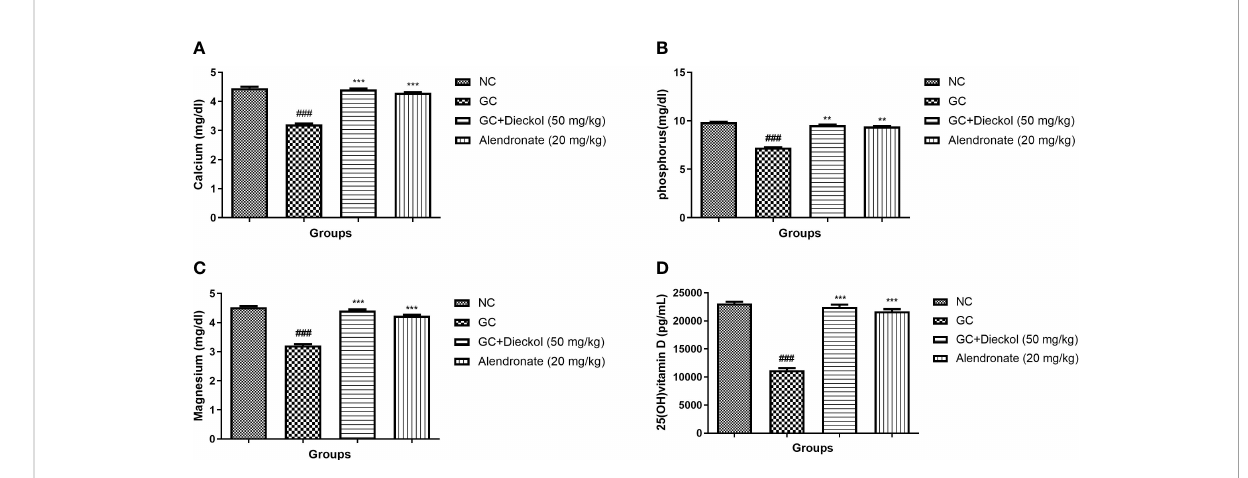
FIGURE 5 Dieckol was shown to protect nutrient parameters against glucocorticoid-induced osteoporosis in rats. (A) Calcium, (B) phosphorus, (C) magnesium, and (D) 25 (OH) vitamin (D) Results are shown as means ± SEM (n = 12). ***P < 0.001 when contrasted with the disease group and the normal